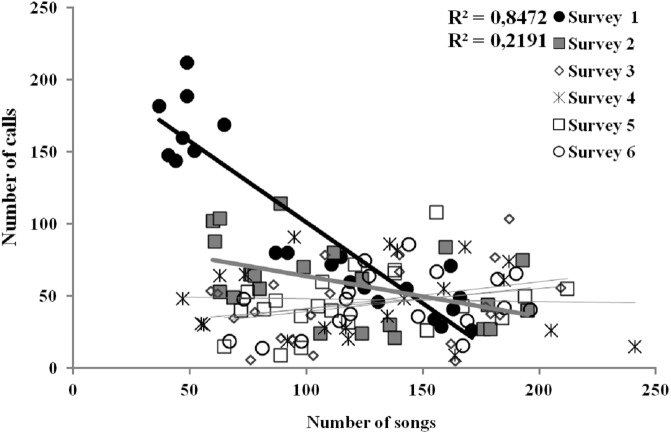
Linear relationships between the number of songs and calls uttered per each Dupont’s Lark male and survey (data of 2013 and 2014 pooled) at Rincón de Ademuz (eastern Spain).Vocal activity was monitored in six surveys, performed fortnightly from late March (First Survey) to early June (Sixth Survey). Surveys with significant Pearson’s correlations are represented with filled symbols and their R2 value can be found in legend (see complete analyses in Table S2).